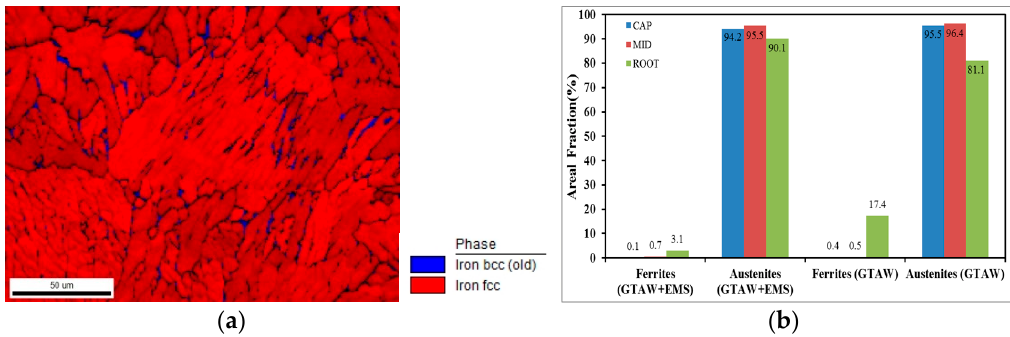
Figure 9. ( a ) The EBSD analysis of the GTAW weld in the middle, and ( b ) the fraction of the austenitic and ferritic phases in the welds.